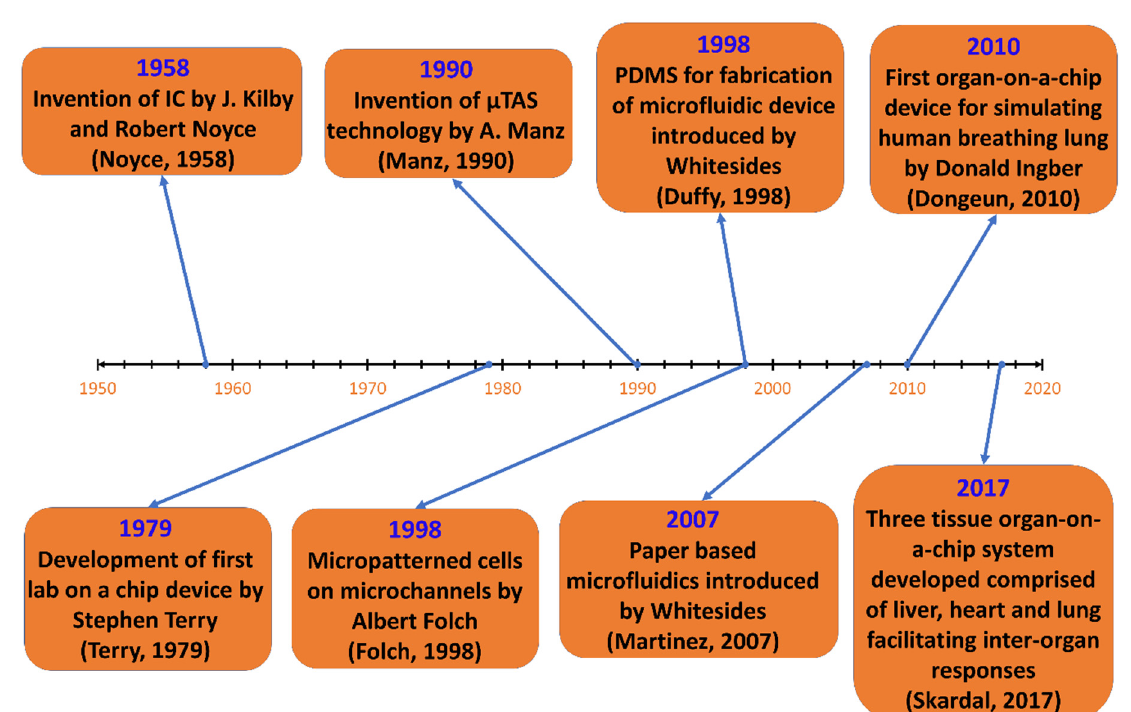
Figure 3. Schematic representation showing the historical development of microfluidic devices.